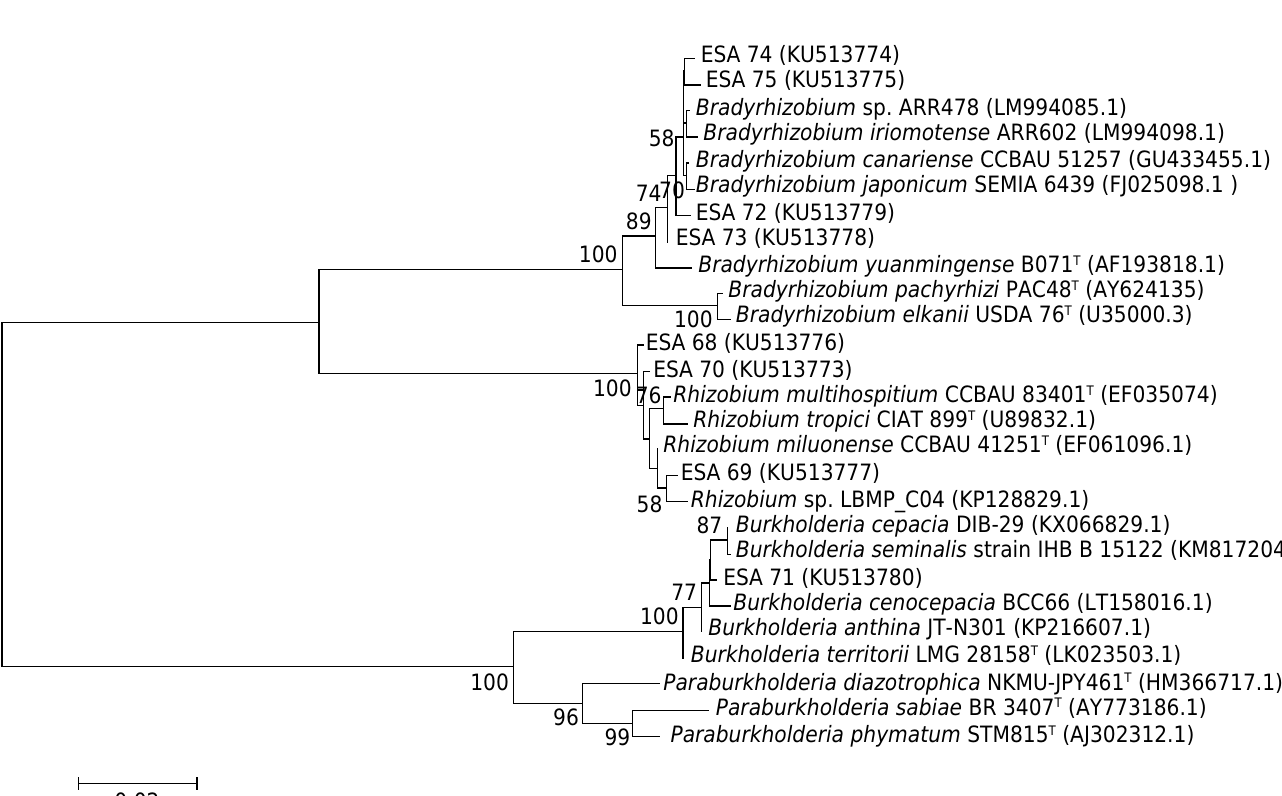
Figure 1. Neighbor-Joining phylogenetic tree based on the partial 16S rRNA gene sequence for eight bacteria from Erythrina velutina and 15 other reference strains (1000 bp). Numbers in the nodes represents the bootstrap value from 1000 replications. Bootstraps values lower than 50 % are not